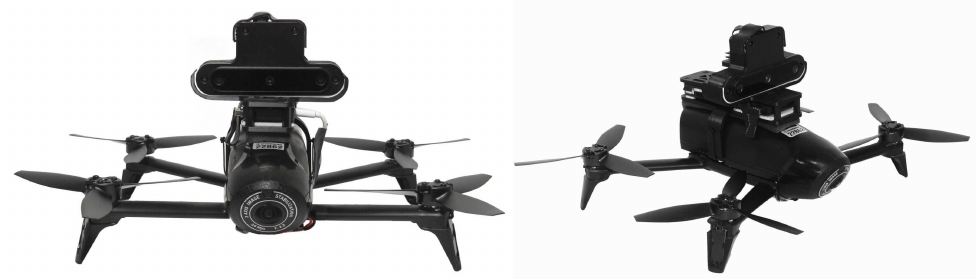
Figure 6. Front and side views of the Bebop 2.0 Power Edition carrying the OAK-D and the Intel Compute